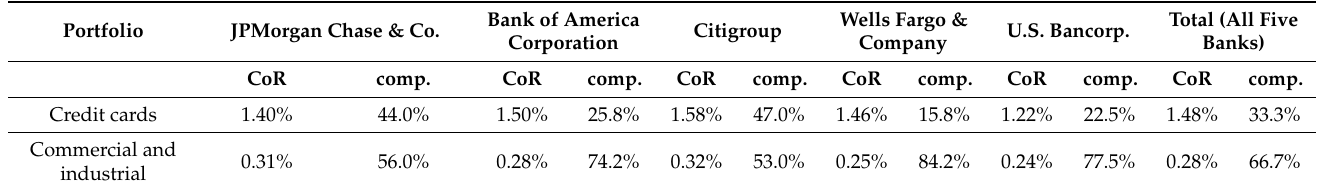
Table 4. Parameter used under Monte Carlo